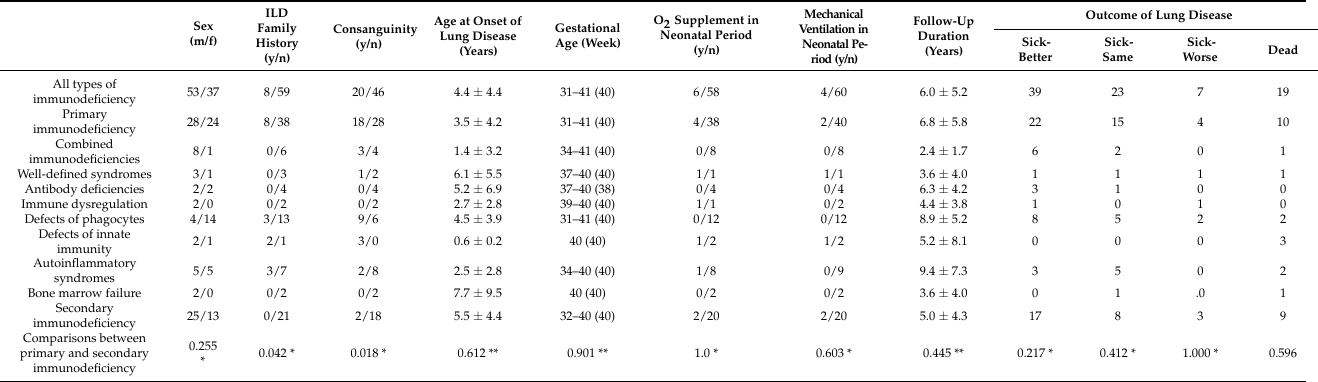
Table 4. History, neonatal period and long-term course of patients with ILD and underlying